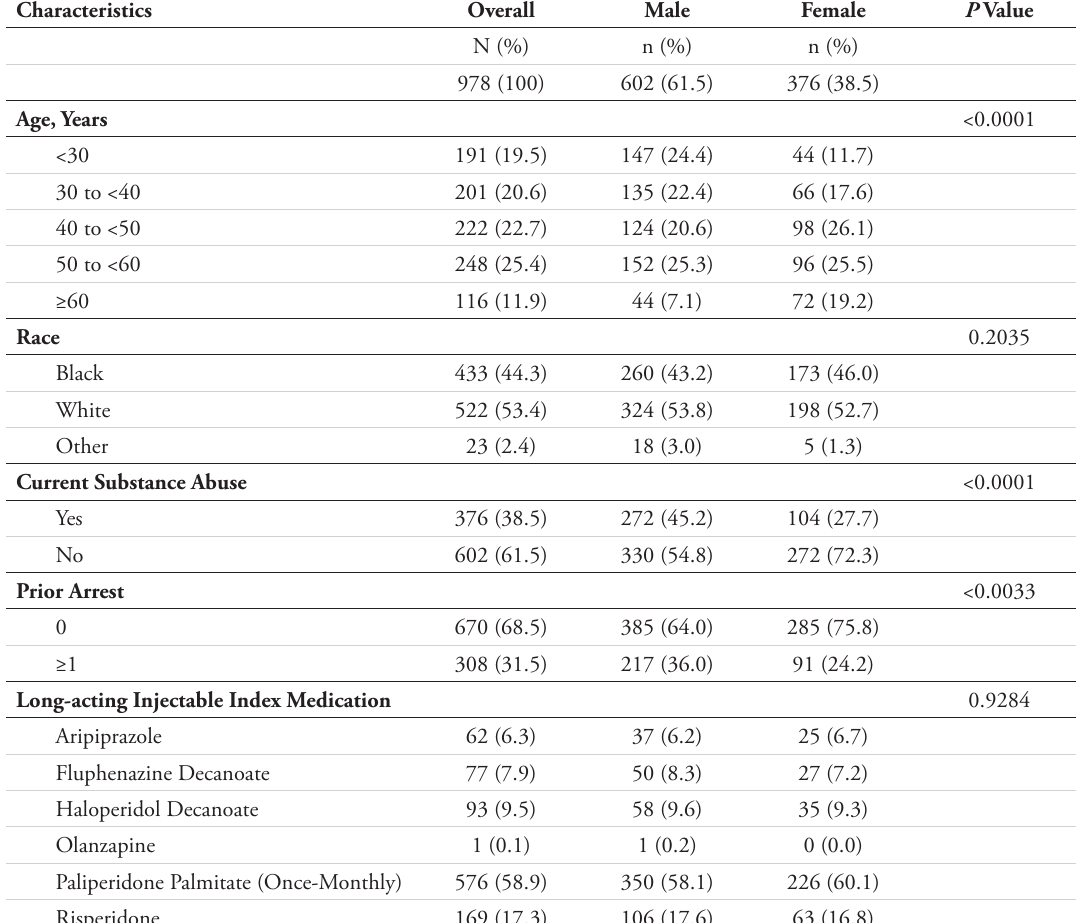
Table 1. Demographics and Baseline Clinical Characteristics of a Cohort of Individuals Receiving Care For Schizophrenia or Schizoaffective Disorder at a Community Mental Health Center